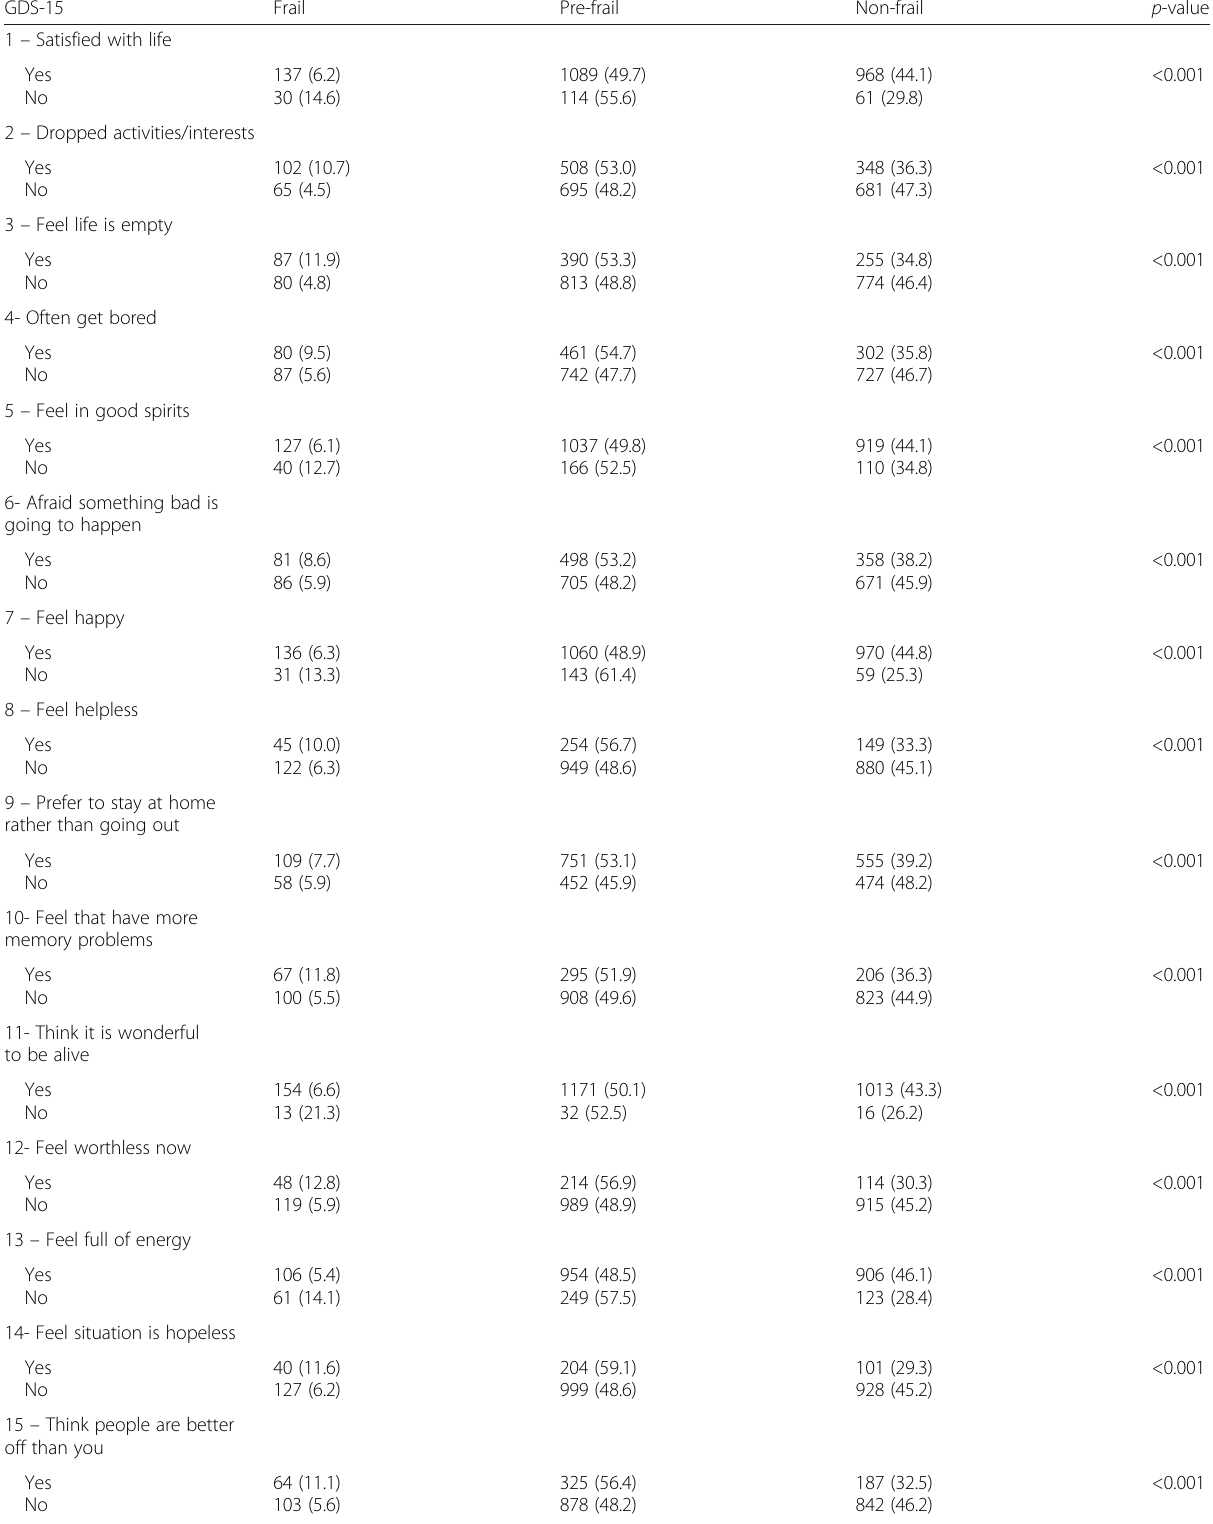
Table 4 Presence or absence of specific depressive symptoms on the GDS among the different frailty profiles ( n = 2399). FIBRA Unicamp, Elderly, 2008 – 2009